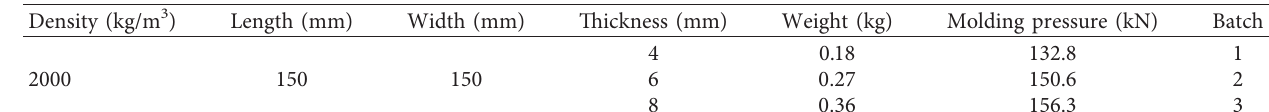
Figure 2: Schematic diagram and physical picture of an equipment base. (a) Schematic diagram. (b) Physical picture. Table 1: Parameters of the EMWM specimens.